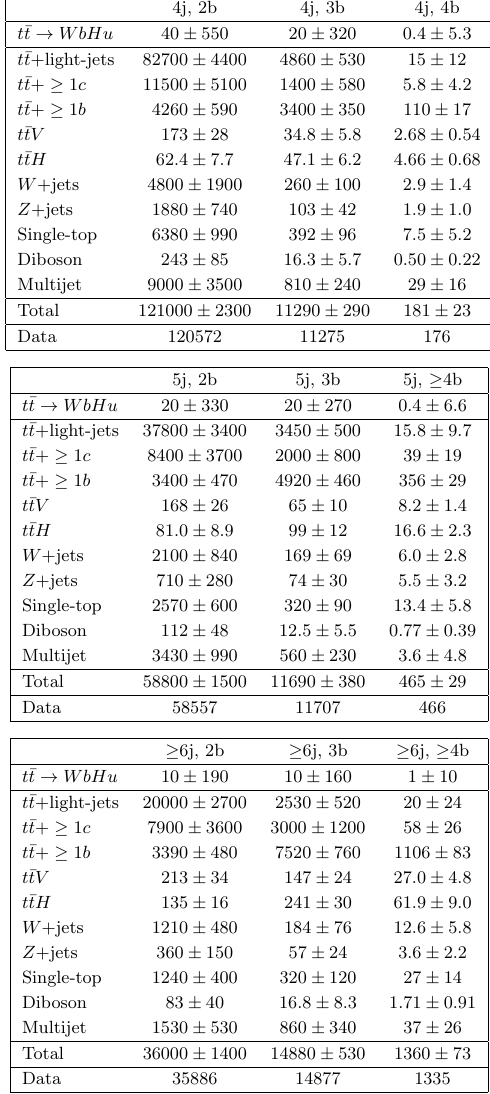
Table 6 . tqH ( b (cid:22) b ) search: predicted and observed yields in each of the analysis regions consid- ered. The background prediction is shown after the (cid:12)t to data under the signal-plus-background hypothesis (assuming t (cid:22) t ! WbHu as signal). The quoted uncertainties are the sum in quadrature of statistical and systematic uncertainties of the yields, computed taking into account correlations among nuisance parameters and among processes.